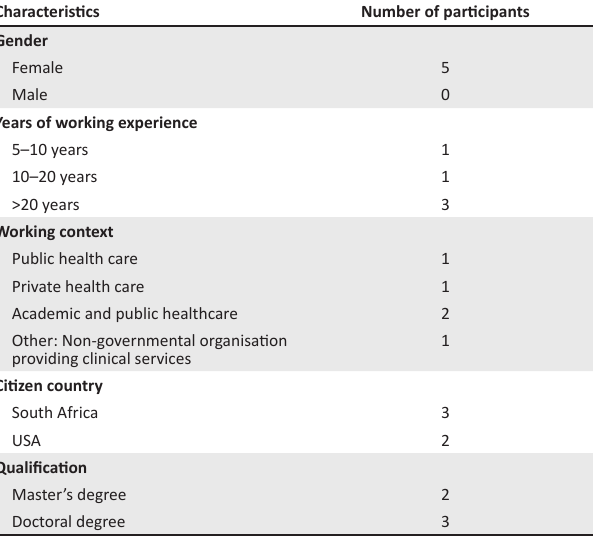
TABLE 1: Participant description ( n = 5).